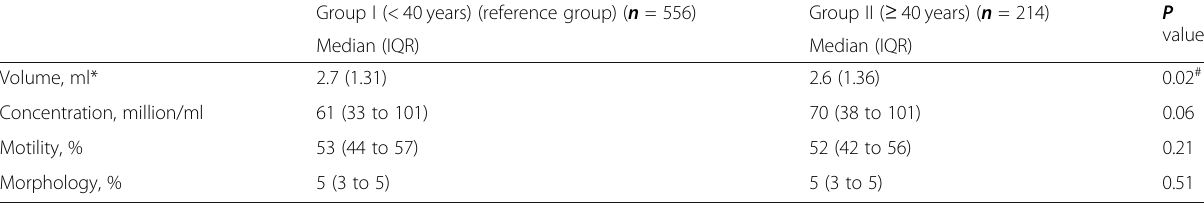
Table 4 Comparison of semen parameters between group I (male partner age < 40 years) and group II (male partner ≥